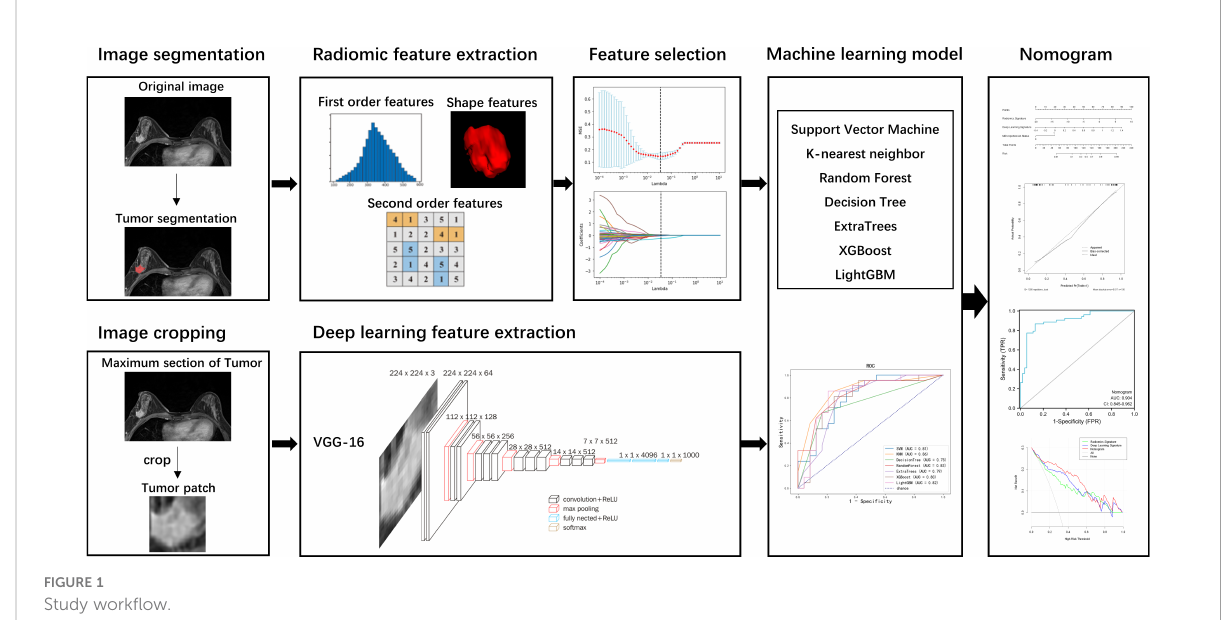
FIGURE 1 Study work fl